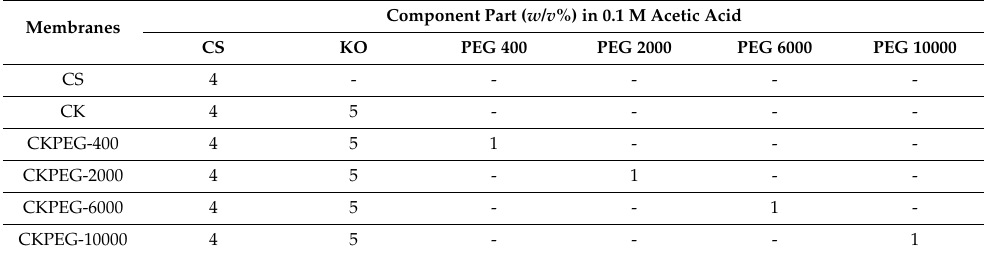
Table 1. Composition of the prepared dope